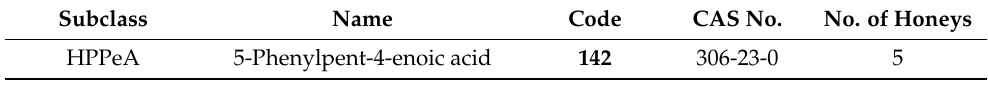
Figure 19. Structure of 5-phenylpent-4-enoic acid, a hydroxyphenylpentanoic acid (HPPeA) ( 142 , Table 13). Table 13. Hydroxyphenylpentanoic acid (HPPeA) reported in monofloral honeys.